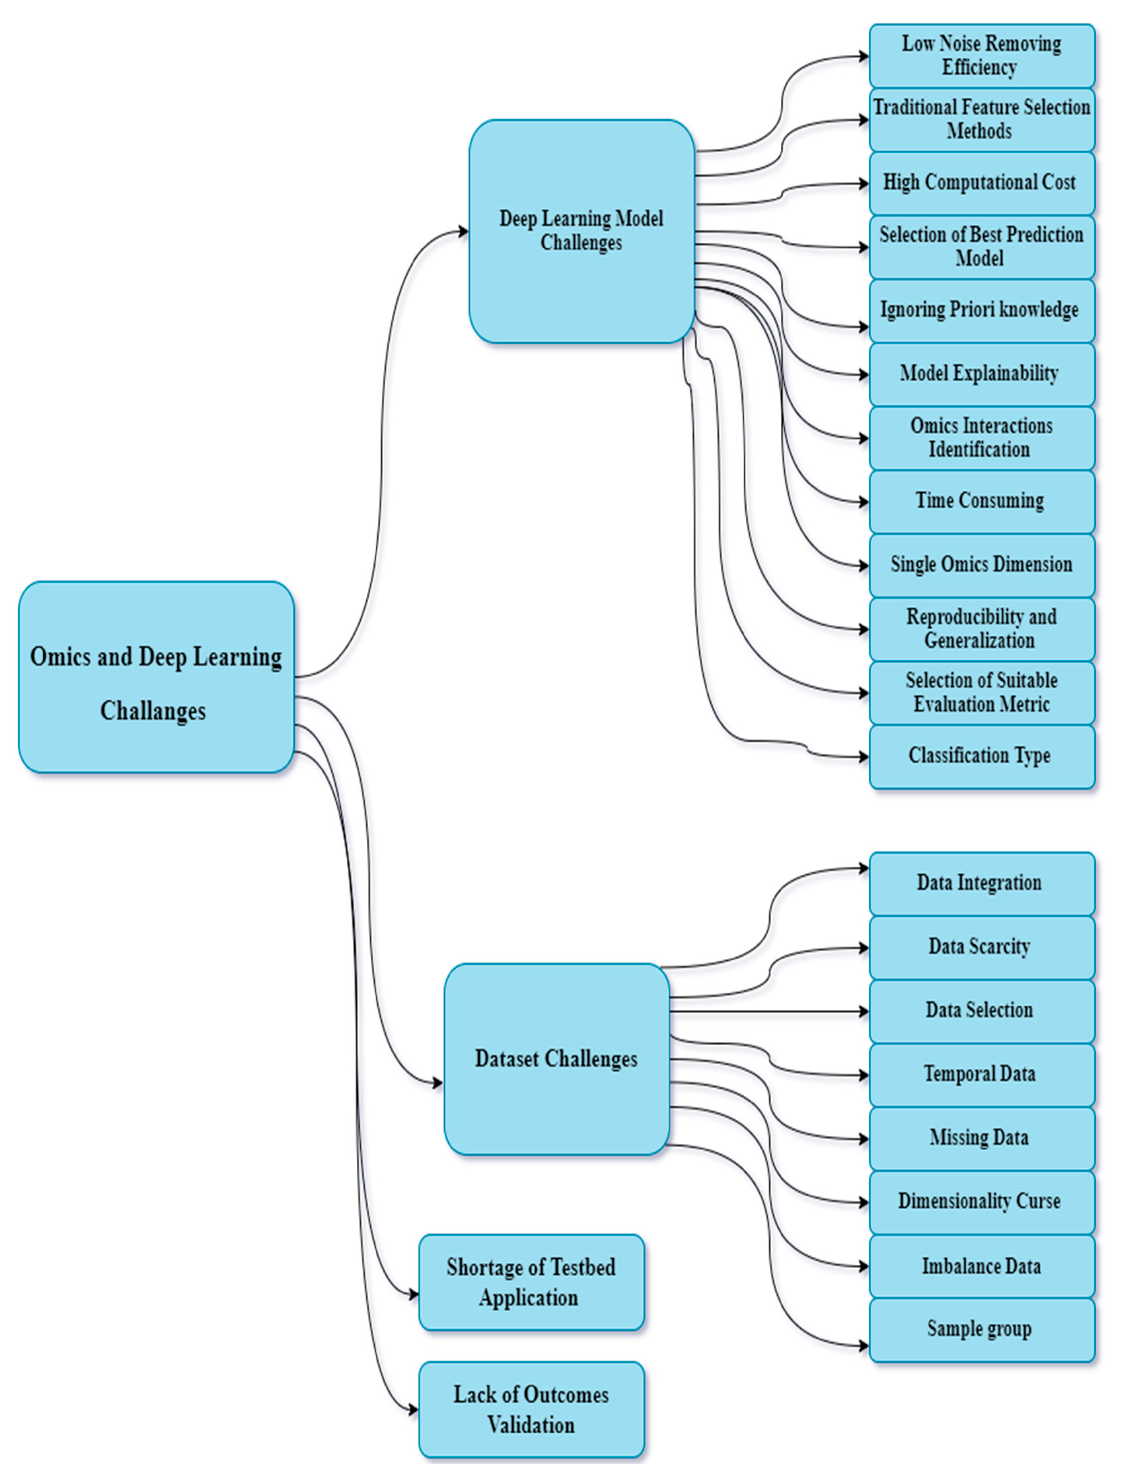
Figure 3. Omics and DL challenges.